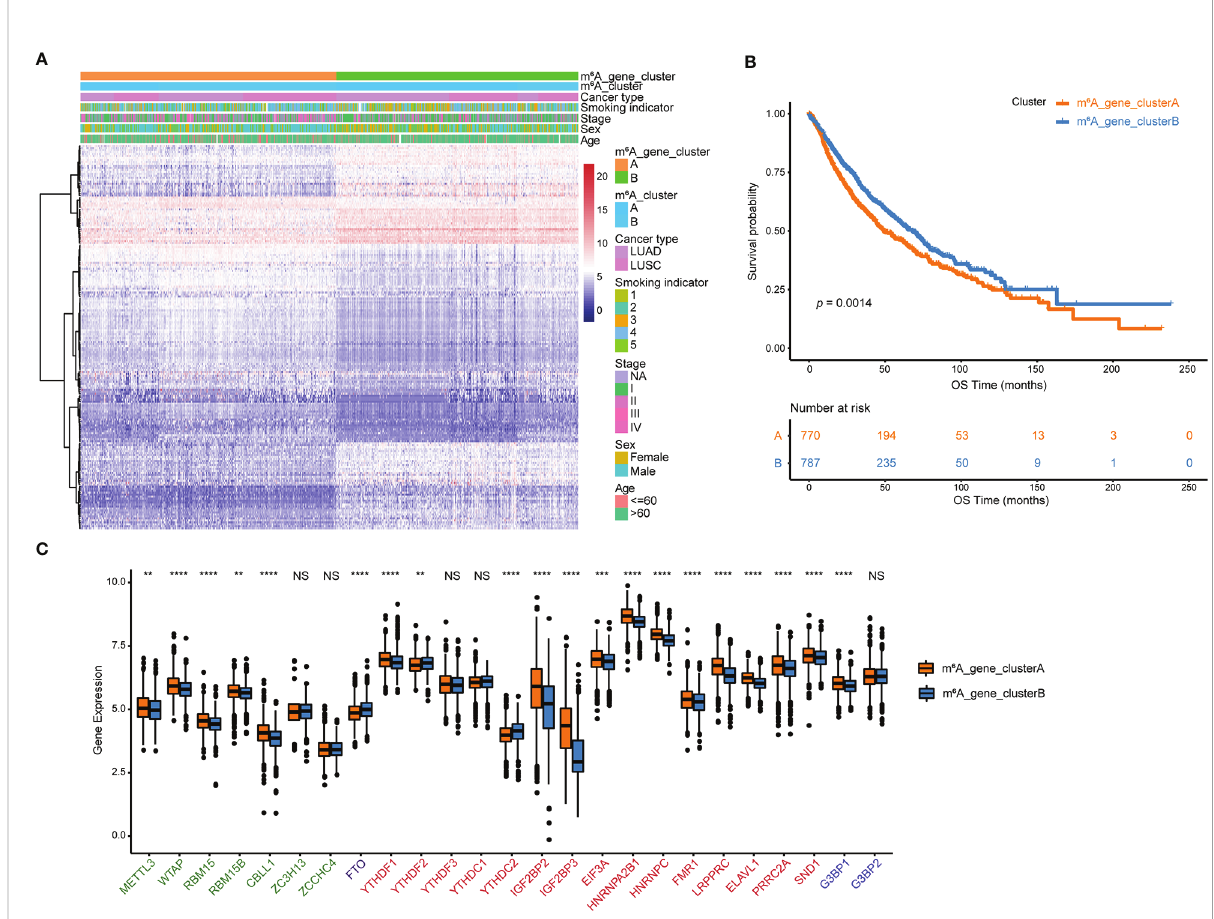
FIGURE 4 Genes that differ in expression are associated with m 6 A. (A) Unsupervised analysis and hierarchical clustering of differentially expressed genes associated with the m 6 A phenotype to divide NSCLC patients into two genomic groups.Patient annotations include m 6 A cluster, cancer type, smoking indicator, stage, sex, and age. (B) Kaplan-Meier curve depicts the association between m 6 A modi fi cation genomic phenotypes and OS. (C) The two m 6 A gene clusters ’ expression of 25 m 6 A regulator genes. NS p > 0.05; ** p < 0.01; *** p < 0.001; **** p <